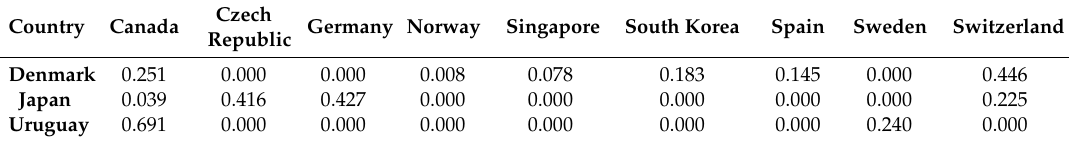
Table 5. Projection of ine ffi cient countries onto the e ffi ciency frontier. Only the shares of Denmark, Japan and Uruguay are hereby displayed. For these three countries, the shares from other countries are null. The full table for all countries is available in the ESI, Table S4. Country Canada